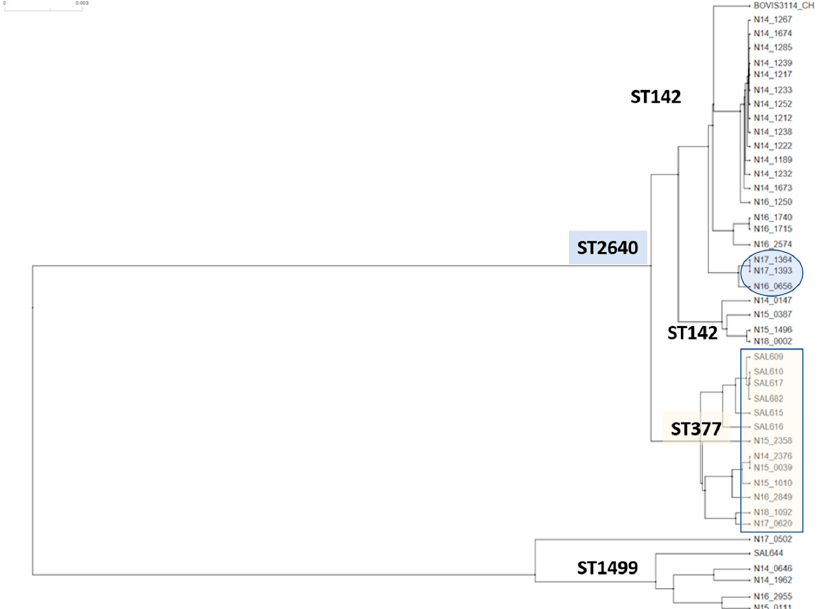
Figure 2. Phylogenetic analysis with wg-core gene SNPs in emerging ST lineages within genome type Cluster 1 of the S. Bovismorbificans serovar. The Cluster 1 consisted of 4 major STs and diverged significantly from ST150 strains of Cluster 2. Even among these related strains in Cluster 1, emerging polymorphisms exhibiting different rates of microevolution were observed using the SNP data matrix. UPGMA tree drawn on SPlitsTree 5.0. Refer to Supplemental File S3 for details of SNPs among the strains of different Cluster 1 STs.